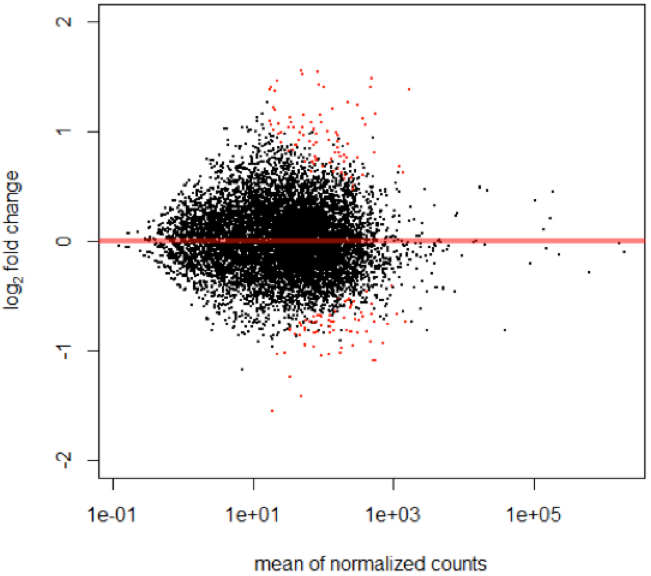
Fig 2. Differential gene expressionbetween SPO3h and SPO12h. The MA plot of mean expression, that is the averageof counts normalized by size factor (x-axis) plotted againstLog2change fold 9y-axis), between schistosomula SPO3h and SPO12h (adjustedp-value < 0.05). Transcripts with positive Log2Change fold are up-regulated in schistosomula after 12hoursof exposureto hamster portal serum, and those with negative Log2Change fold are up-regulated after 3hoursexposure to the portal serum. The red spots represent transcripts with p-values < 0.1, as default.